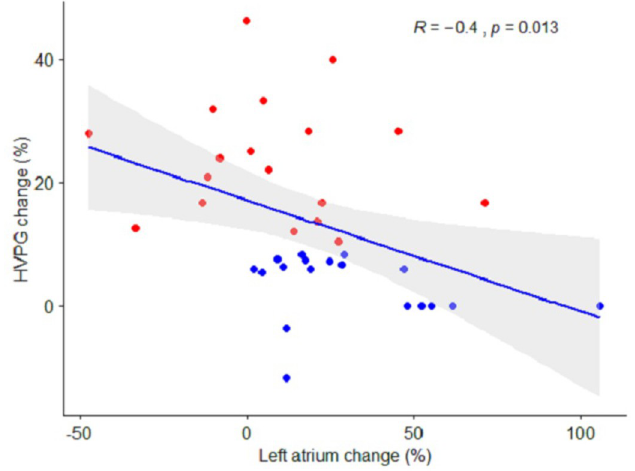
Fig 3. Correlation between changes in portal pressure and size of the left atrium. The impact of beta-blockers on size of the left atrium in relation to the beta-blocker response on portal pressure. The grey area indicates a 95% confidence interval. Red plots: patients classified as responders. Blue plots: patients classified as non-responders.